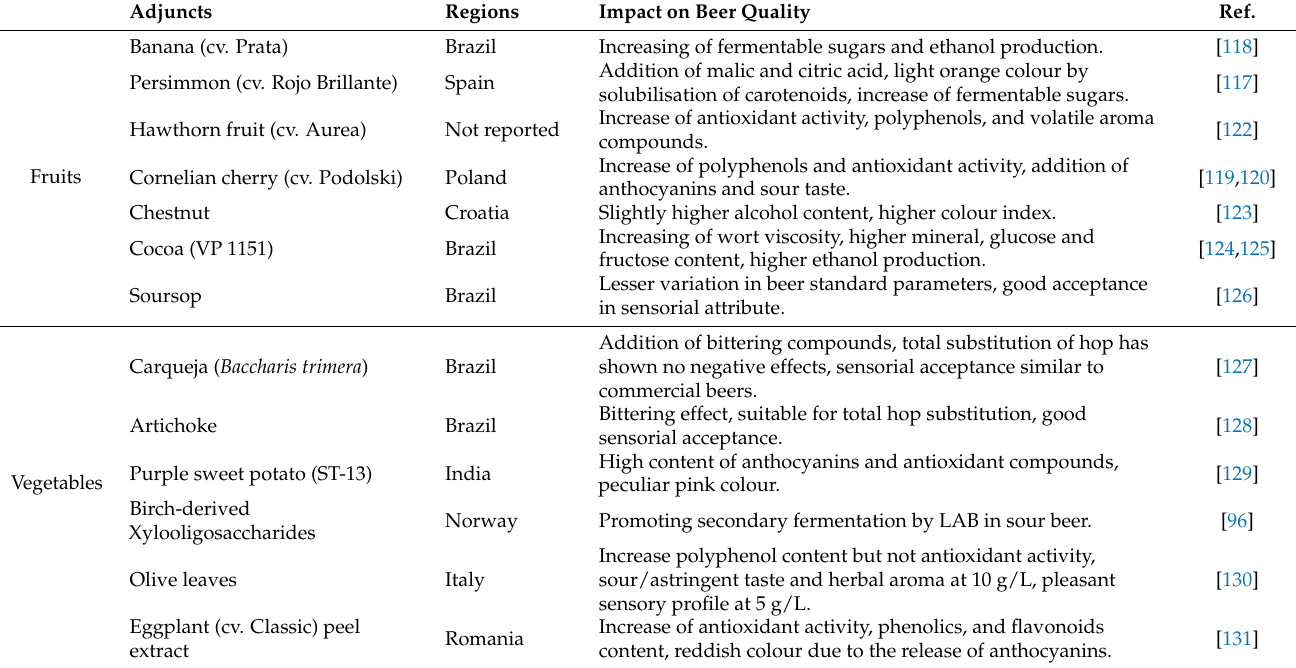
Table 4. Cultivars, origins, and impact of adjuncts recently investigated for their brewing potential. Adjuncts Regions Impact on Beer